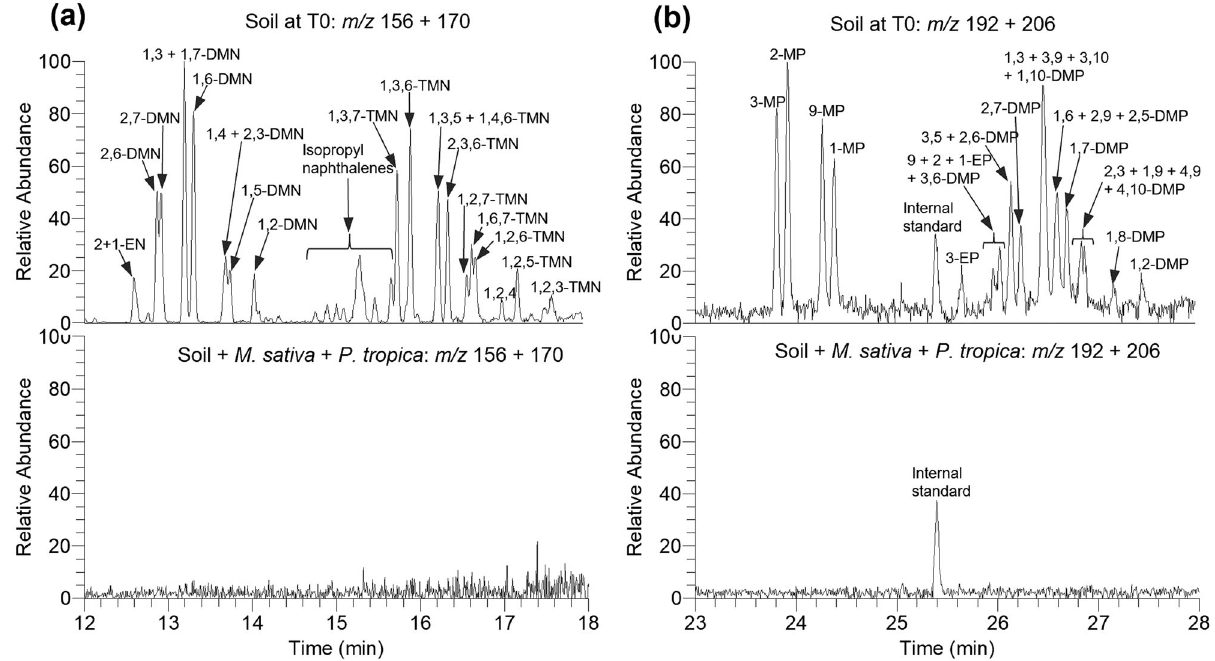
Fig. 3 Biodegradation of polycyclic aromatic hydrocarbons. a Partial m/z 156 + 170 and b m / z 192 + 206 mass chromatograms of contaminated “ soil at T0 ” and “ planted and inoculated soil ” at the end of the experiment, showing effective biodegradation of alkylnaphthalenes and alkylphenanthrenes by the combined actions of M. sativa and P. tropica . EN ethylnaphthalene, DMN dimethylnaphthalene, MP methylphenanthrene, EP ethylphenanthrene, DMP dimethylphenanthrene. Numbers denote positions of